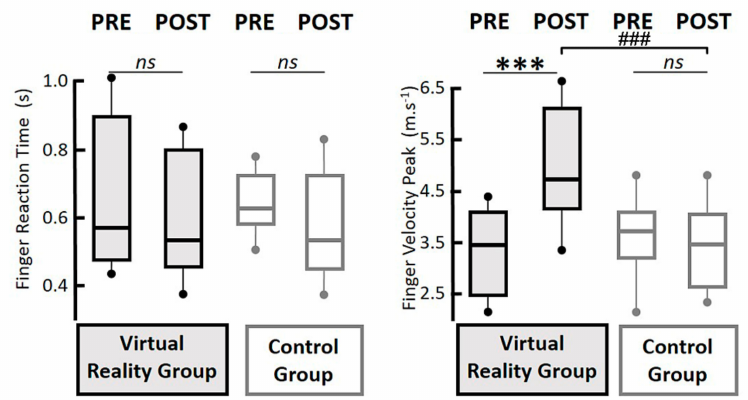
Figure 4. Boxplot graphs. In each reported parameter, the box and whiskers report the values of all the recordings for all participants. The box is defined by the first and third quartiles. The thick line within the box represents the median value. The tenth and ninetieth percentiles are plotted as circles above and below the whisker bars. All participants in the VR group are reported in black lines with a grey area, and the CTRL group in grey lines with a white area. In the left panel, the boxplots represent the finger reaction times in seconds. In the right panel, the boxplots represent the finger velocity peaks in m.s − 1 , according to the pre- and post-test sessions (upper line). ns, p > 0.05; ***, p < 0.001 between the pre- and post-tests within the VR group; ###, p < 0.001 between the post tests in the virtual reality group and the pre/post-tests in the control group.